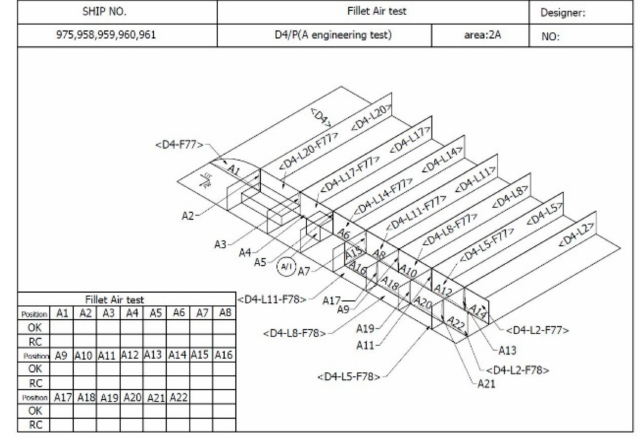
Figure 11. A engineering pressure test.